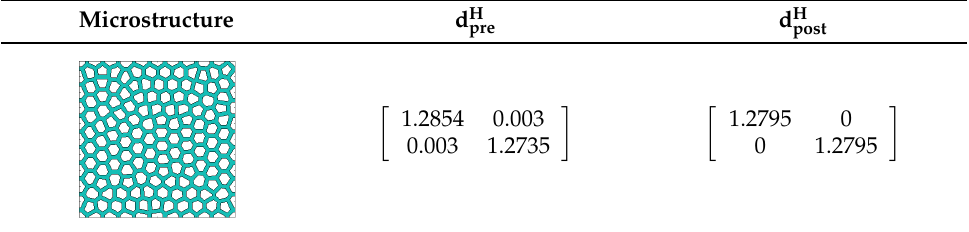
Table 1. Results of the homogenized heat conductivity matrix. Microstructure